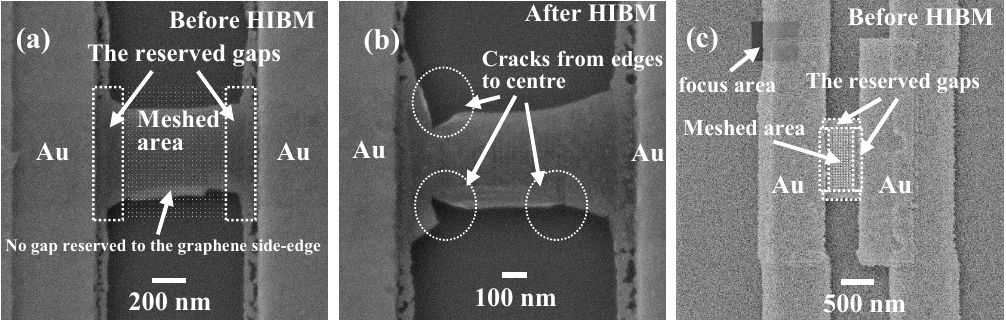
Figure 5. ( a ) Certain gaps reserved between the meshed area and metal layer. ( b ) The same device in (a) after HIBM, in which cracks were observed starting from the edges. ( c ) 100 nm gaps on the top and bottom, 50 nm gaps on the left and right. The focus area was located on the metal layer.